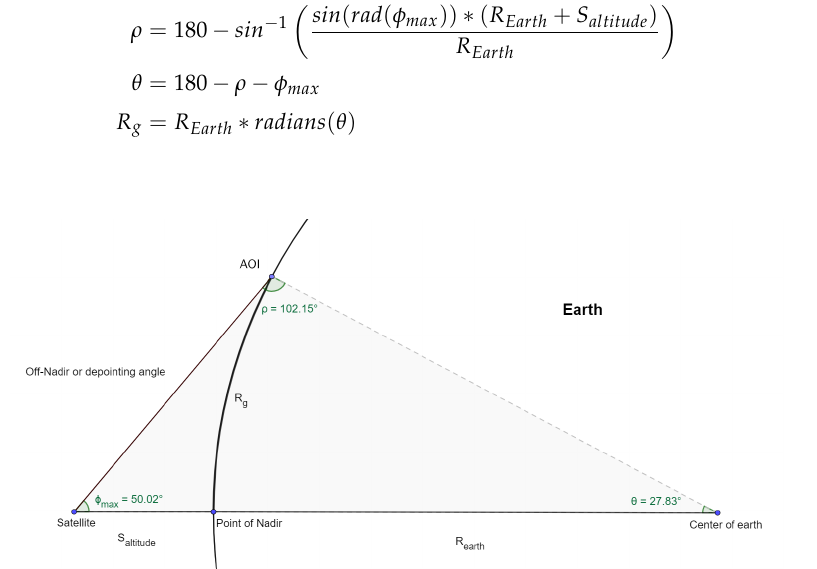
Figure 4. Exaggerated illustration of trigonometric relationship between maximum off nadir angle of satellite, its altitude, and the ground reachability. Practically, Φ max = 30 ◦ , and the distance S altitude relative to R earth is much smaller, resulting in a much more obtuse triangle of